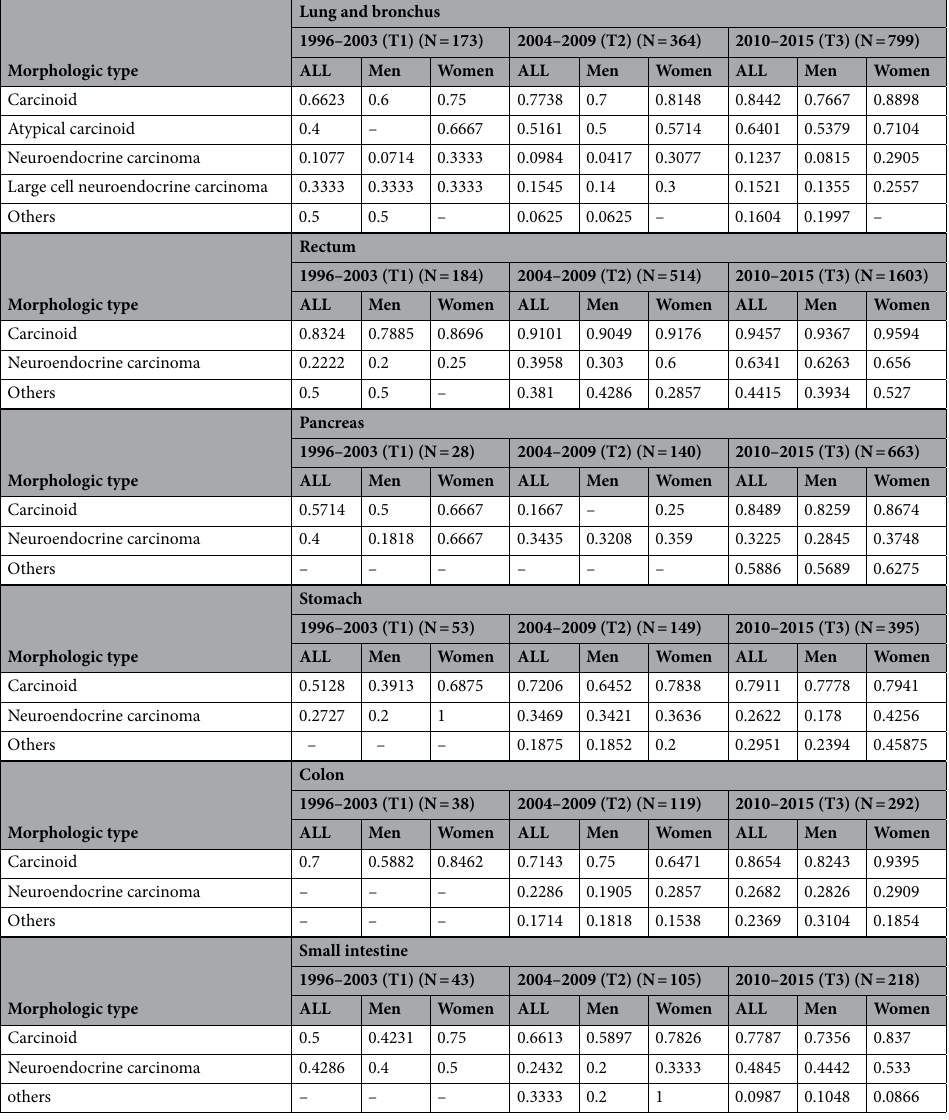
Table 6. The 5-year overall survival rate of NETs in the 6 most common sites. –: not